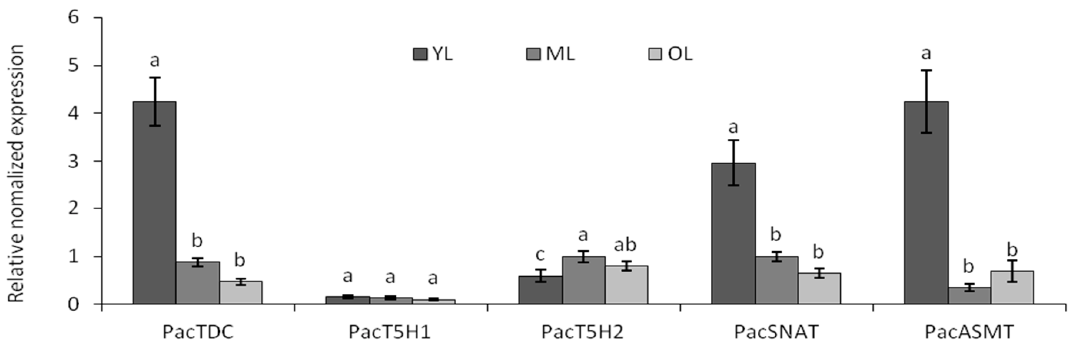
Figure 3. The transcriptional expression level of PacTDC, PacT5H1, PacT5H2, PacSNAT , and PacASMT during leaf development in Hongdeng. YL: young leaves; ML: mature leaves; OL: old leaves. Data are shown as mean ± SE with three biological replicates, di ff erent letters indicate significant di ff erences at p < 0.05